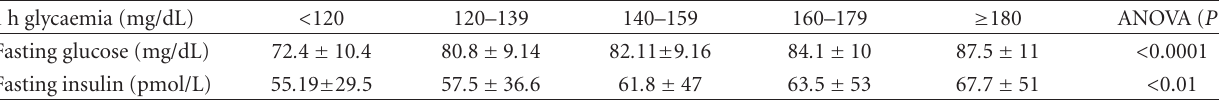
Table 2: Fasting glucose and insulin levels related to 1-hour glucose values during OGTT (data are means ± SD). 1h glycaemia